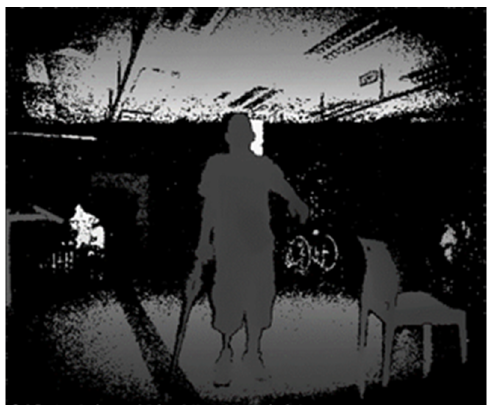
Figure 7. An example of SFL gesture performed by P2 holding a